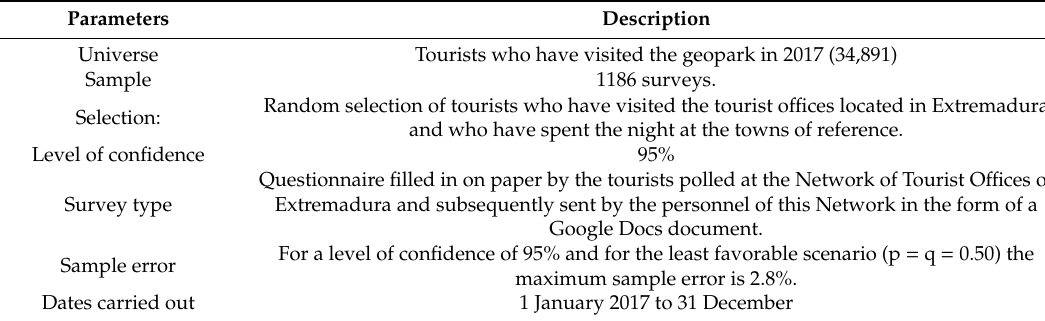
Table 3. Details of the survey carried out of the tourists.